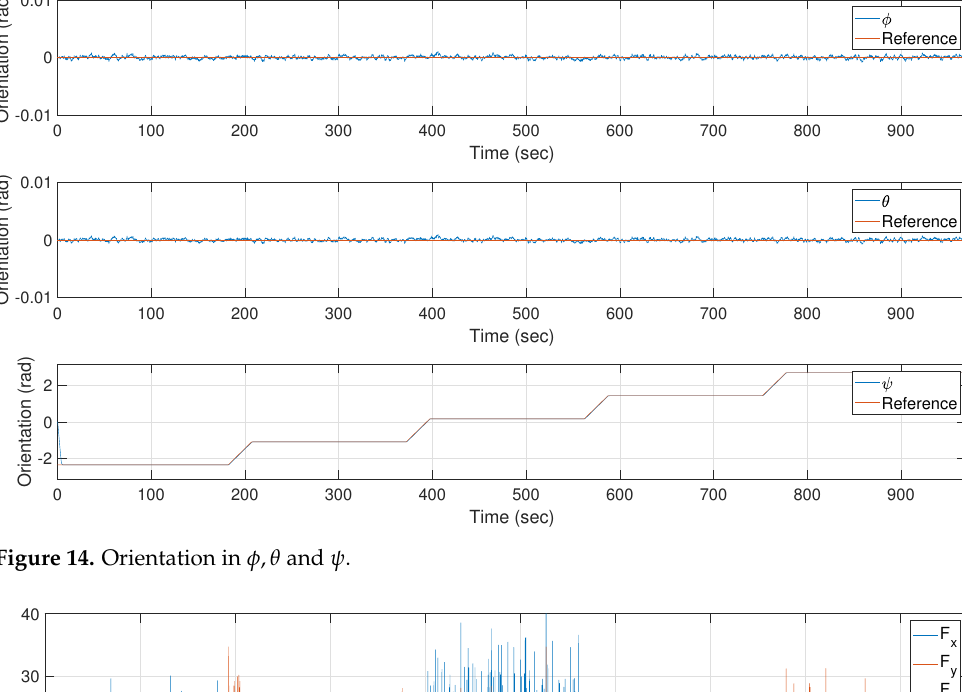
Figure 14. Orientation in φ , θ and ψ .